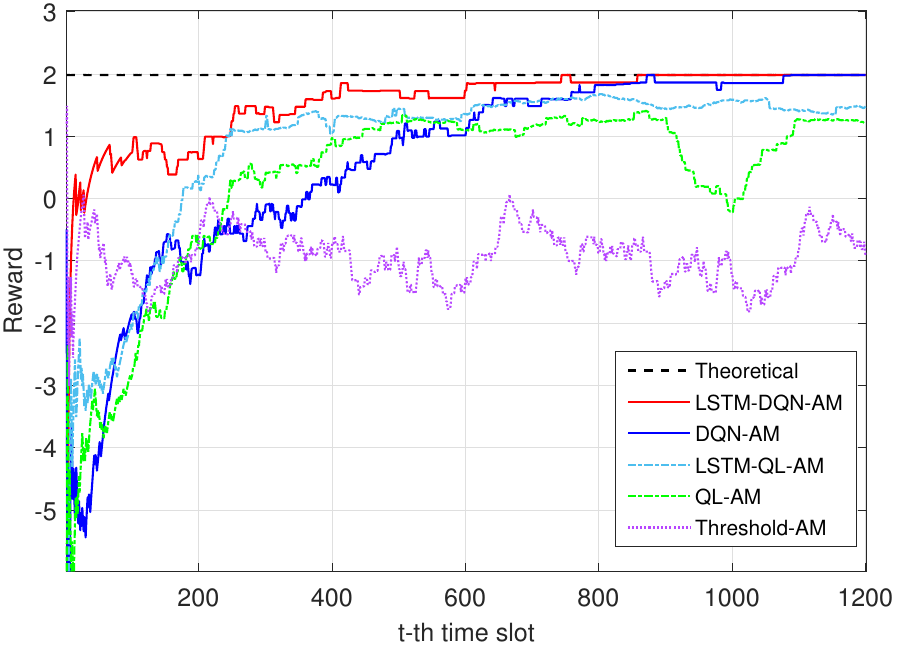
Figure 8. The rewards from the AM schemes in the pool experiments. Table 2. A comparison of the rewards of the different AM schemes in the pool experiments. AM Scheme Compared AM